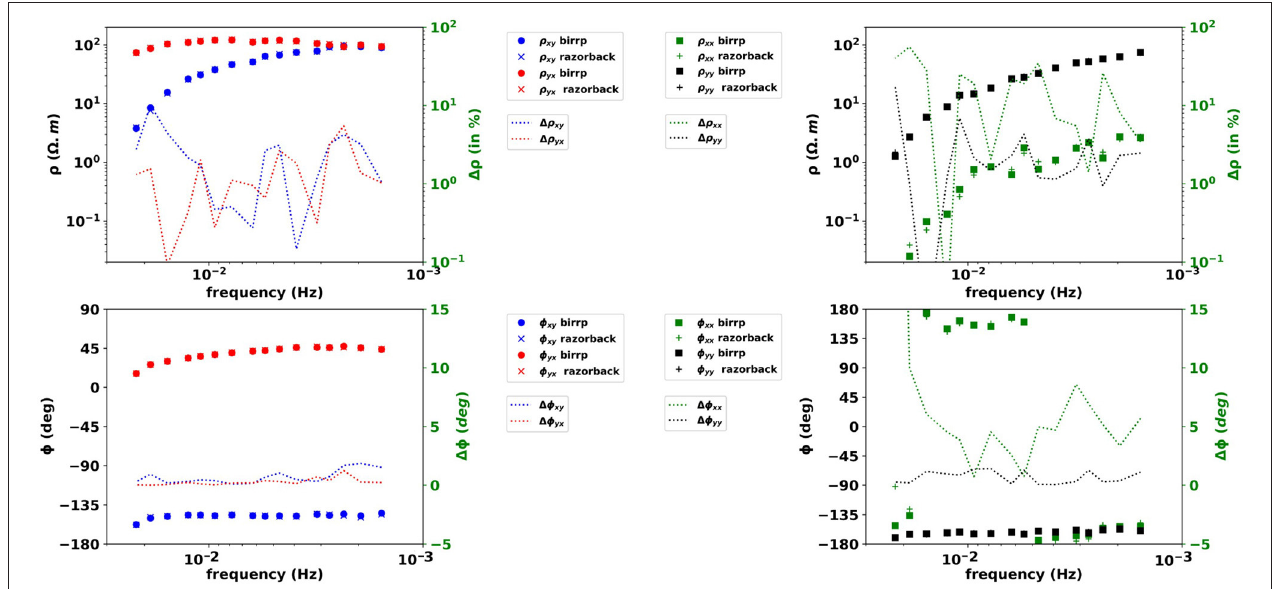
FIGURE 2 | M-estimator results in SS configuration. Upper left: apparent resistivity xy in blue and yx in red from birrp (circles) and razorback (crosses) with scales on the left axis, relative differences between birrp and razorback results (dotted lines) for xy (blue) and yx (red) with scales on the right axis. Lower left: same as upper left but for phase but with absolute differences (dotted lines). Upper Right: apparent resistivity xx in green and yy in black from birrp (squares) and razorback (plus) with scales on the left axis, relative differences between birrp and razorback results (dotted lines) for xx (green) and yy (black) with scales on the right axis. Lower Right: same as upper left but for phase but with absolute differences (dotted lines).